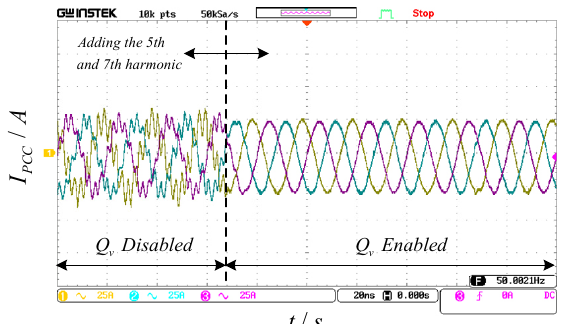
Figure 30. Experimental result of current waveform at PCC after injecting harmonic voltage.